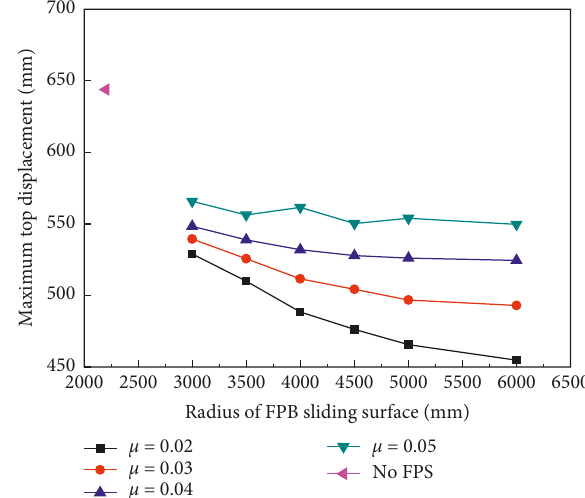
Figure 23: The maximum drift of T4 tower with R direction under L0223S wave.